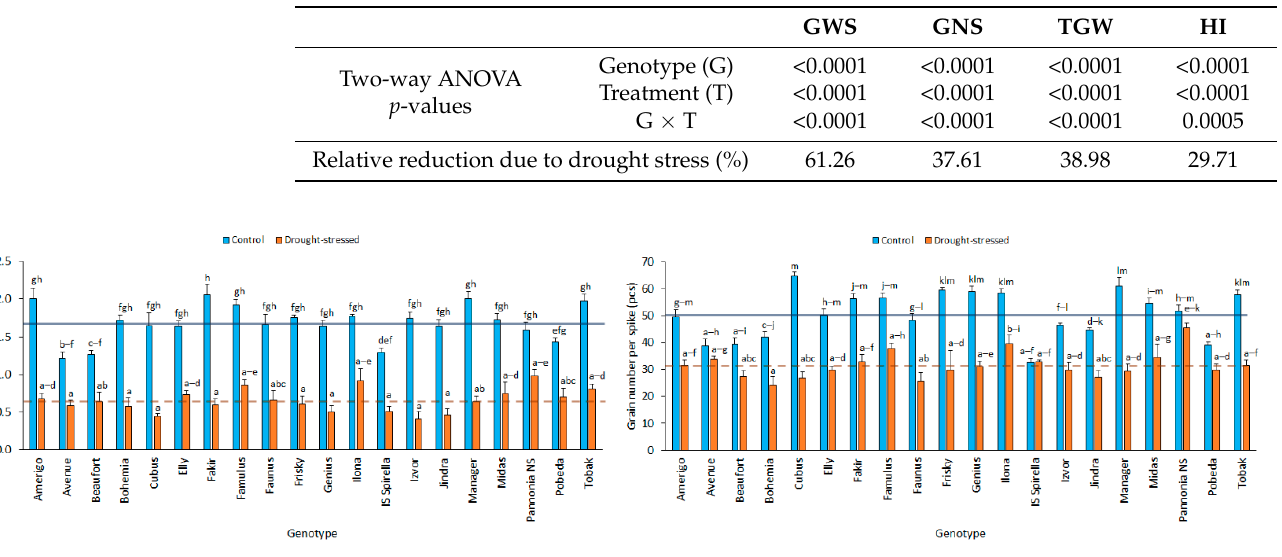
Table 2. Results of a two-way ANOVA for individual yield formation parameters and their relative reductions due to drought stress.